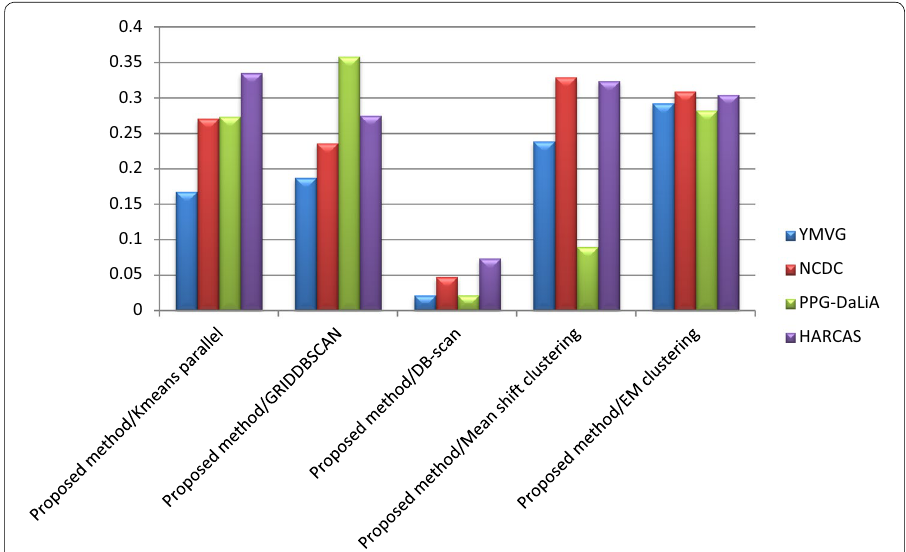
Fig. 5 Percentage of improvement for execution